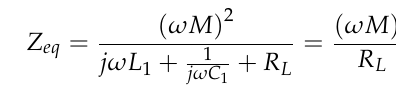
Figure 3. The SS compensation Witricity circuit using the equivalent circuit A.